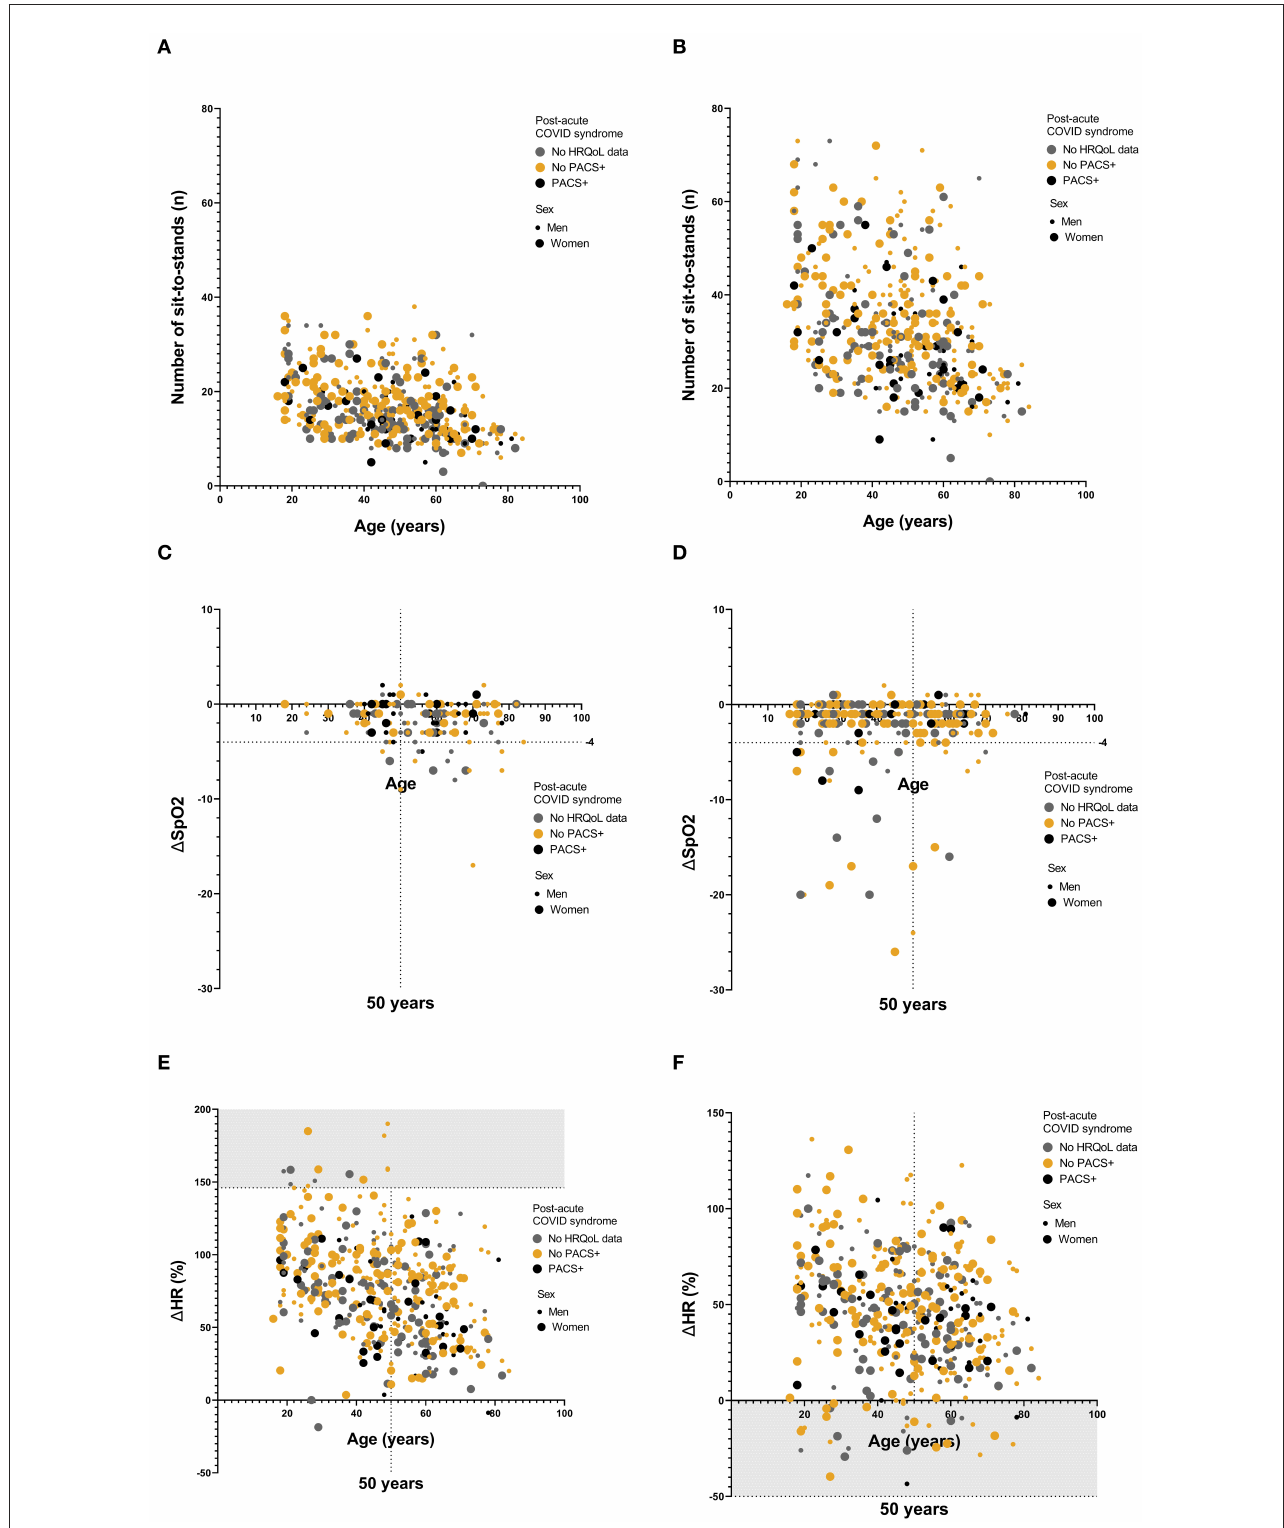
FIGURE2 (A–F) Results from 1MSTST presented by number of sit-to-stands, oxygen saturation and heart rate. (A) Number of sit-to-stands at 30s for the whole cohort. Age in years presented on the x -axis. Numbers presented are the minimum values observed for each study participant between 4 weeks and 6 months. PACS + , black, non-PACS + , yellow and values for patients with no recorded HRQoL data, in gray. Women, large dot; men, small dot. Median values were 14 (range: 5–27) for PACS + , vs. 17 (range: 6–38) for non-PACS + , p = 0.021 (Mann-Whitney U -test). (B) Number of sit-to-stands at 60s for the whole cohort. Age in years presented on the x -axis. Numbers presented are the minimum values observed for each study participant between 4 weeks and 6 months. PACS + , black, non-PACS + , yellow and values for patients with no recorded HRQoL data, in gray. Women, large dot; Men, small dot. Medians: 26 (range: 9–55) for PACS, vs. 33 (range: 10–73) for non-PACS + , p = 0.005 (Mann-Whitney U -test). (C, D) Values of delta-SpO2 after 1MSTST, divided by hospitalized (C) and non-hospitalized (D) . PACS + , black, non-PACS + , yellow and values for patients with no recorded HRQoL data, in